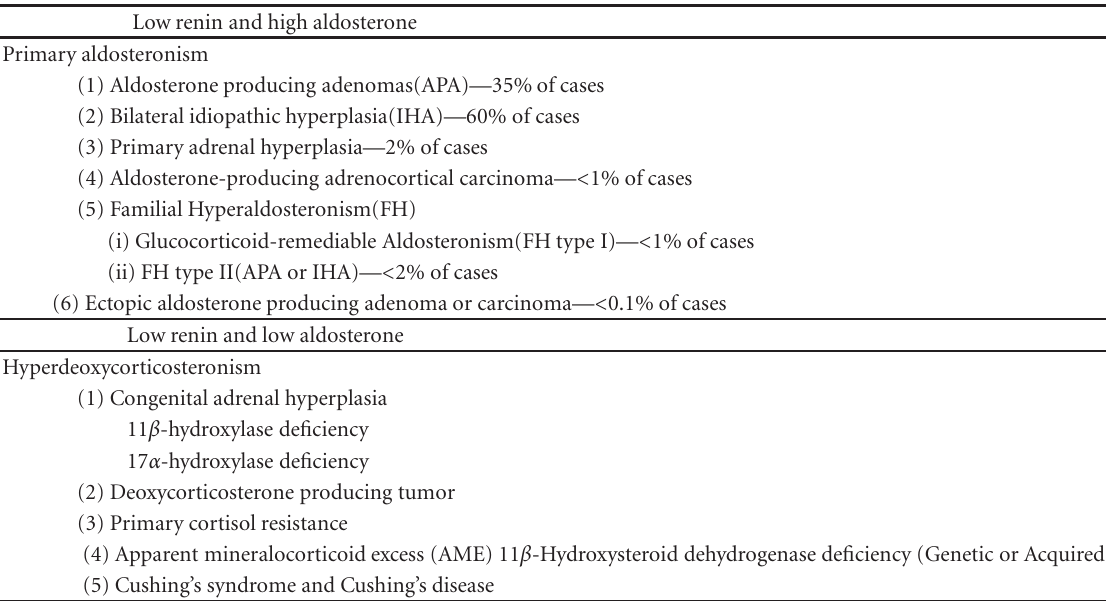
Table 2: Adrenocortical causes of